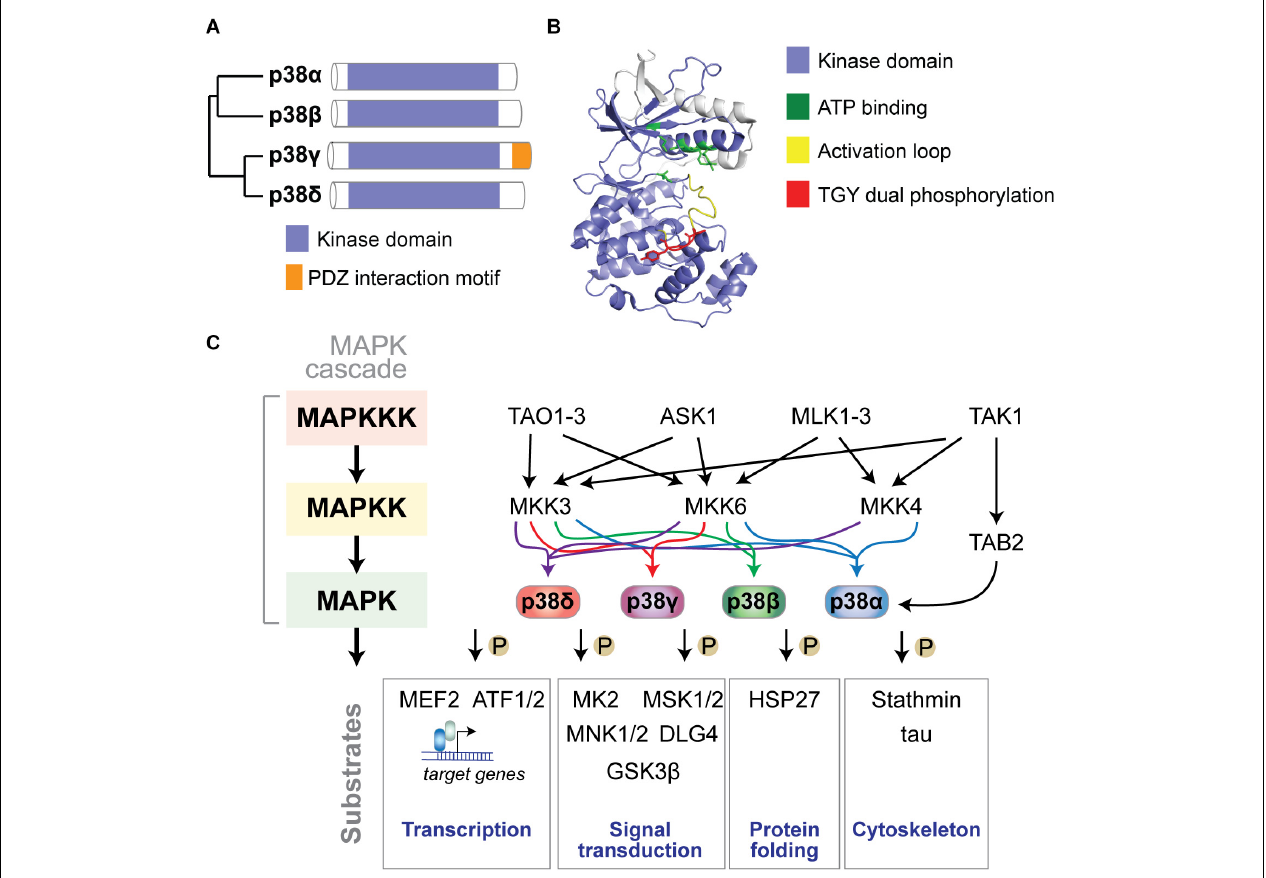
FIGURE 1 | The p38 MAP kinase signaling pathway. (A) Dendrogram of the four mammalian p38 MAP kinases p38 α , p38 β , p38 γ , and p38 δ . Kinase domain and unique PDZ interaction motif in p38 γ are highlighted. (B) Structure of p38 α showing N- and C-lobes of the kinase domain with the active site in between. ATP binding site, activation loop and TGY dual phosphorylation are highlighted. The active site is covered by the activation loop, which undergoes dual phosphorylation resulting in conformation change, access of substrates to the active site and full kinase activation. Structure was reproduced from PDB 3HVC using Pymol. (C) Mammalian p38 kinases comprise of 4 proline-directed serine/threonine kinases - p38 α , p38 β , p38 γ , and p38 δ – encoded in 4 individual genes. p38 MAP kinases are activated by a plethora of extrinsic (extracellular) or intrinsic (intracellular) factors. The classic activation of p38 follows a three-tiered mechanism. Stimuli of p38 activation are cellular stressors such as oxidative stress, inflammatory stimuli/cytokines, UV radiation, and osmotic pressure at cell membranes. Upstream stimuli activate a MAP kinase kinase kinase (MAPKKK) such as ASK1, TAK1, MLK or TAO kinases, which in turn phosphorylate and activate a MAPKK, such as MKK3, MKK4 or MKK6, which in turn phosphorylates p38 kinases on Threonine and Tyrosine residues in the activation loop. Dual phosphorylation of p38 can be detected by phospho-specific antibodies as a marker of activated p38. Dual-phosphorylated p38 is fully active and targets downstream phosphorylation substrates to alter their structure, activity, function, localization or interaction with other biomolecules. An alternative activation mechanism of p38 α downstream of TAK1 involves direct interaction with TAB2 followed by auto-phosphorylation of p38 α . Classic downstream targets of p38 kinases include transcription factors (e.g., ATF-1/2 and MEF2), chaperones (e.g., HSP27), cytoskeletal regulators (stathmin, tau), and other signaling factors (e.g., MAPKAP kinase 2/3, MSK1/2, MNK1/2, DLG4, and GSK3 β ). Feedback inhibition of p38 kinases occurs through dephosphorylation by MAP kinase phosphatases (e.g., MKP1), limiting activity of